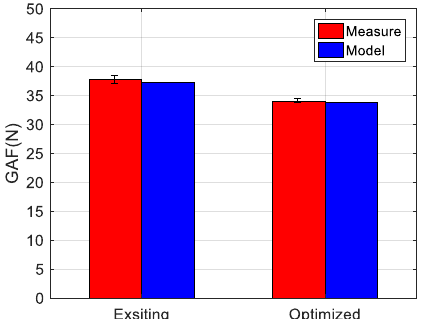
Figure 15. GAF comparison between existing and optimized parameters.